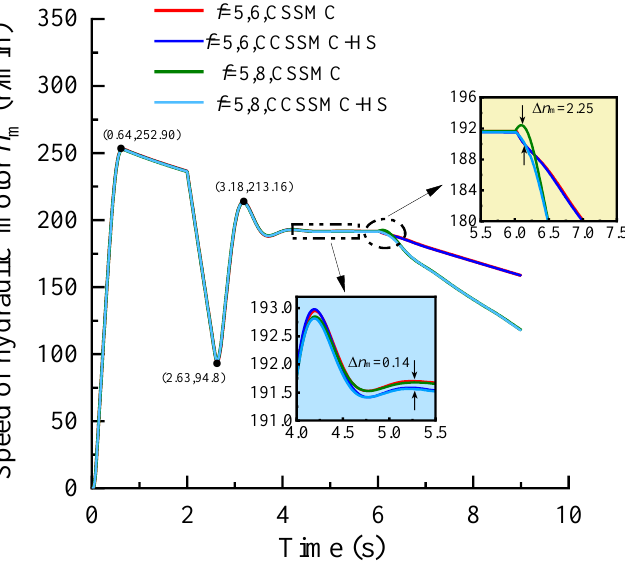
Figure 14. Variation curve of the hydraulic motor speed based on the CSSMC and CSSMC-HS.